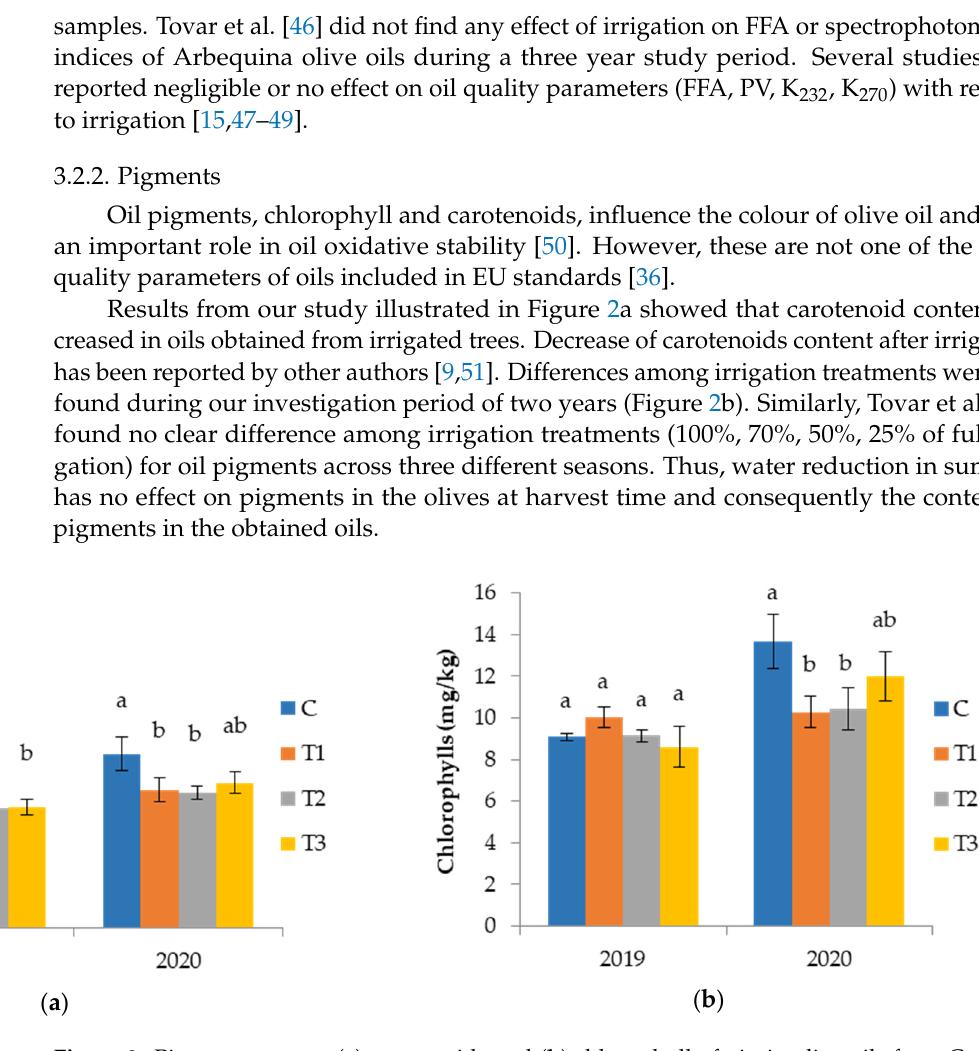
Table 5. Fatty acid profile (%) of virgin olive oils from Coratina cv. olive trees grown under different watering regimes during two crop seasons (2019 and 2020). 2019